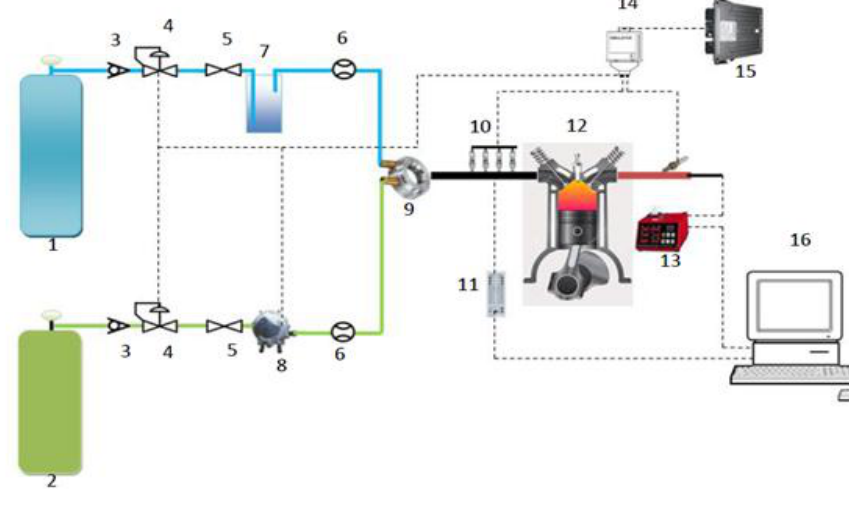
Figure 8. Schematic diagram of bench parts.